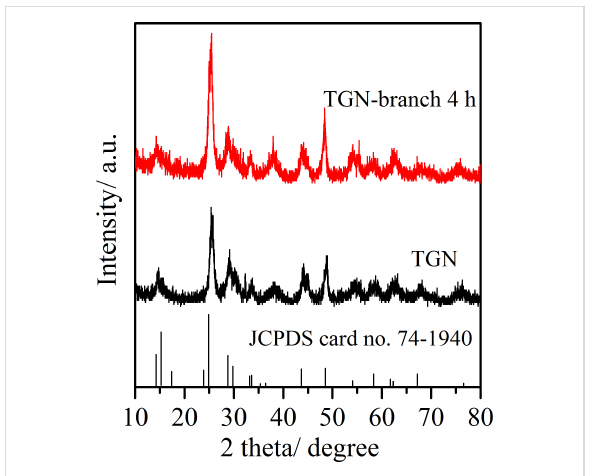
Figure 1: X-ray diffraction (XRD) patterns of TiO 2 (B)/rGO nanobelts (TGN) and branched TiO 2 (B)/rGO nanobelts (TGN-branch 4 h).